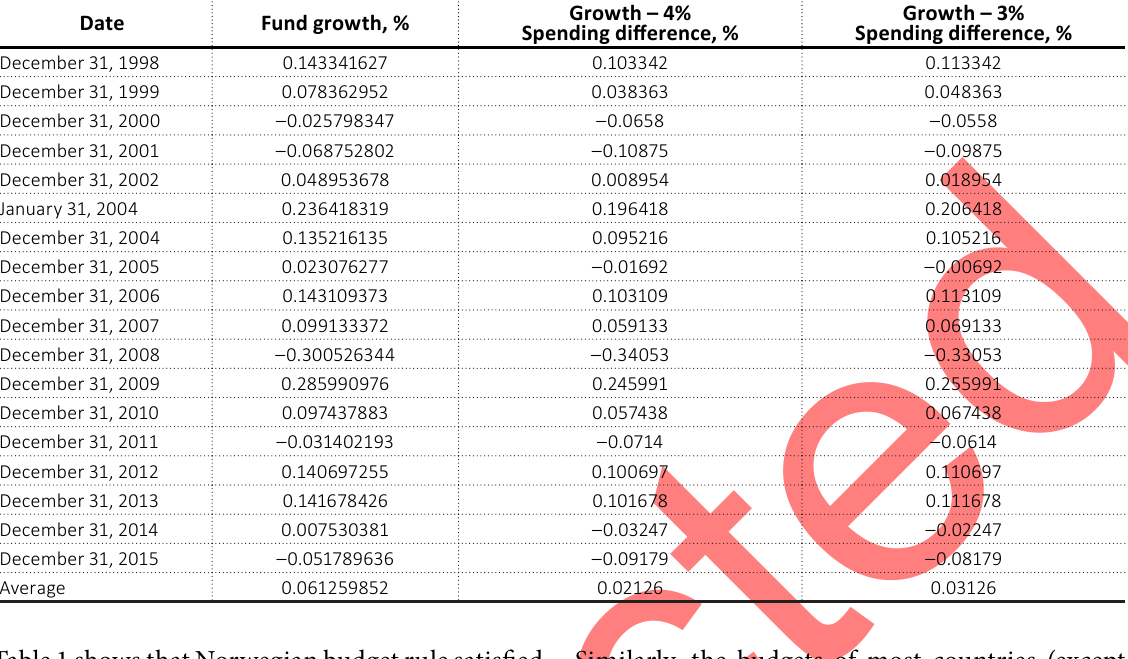
Source: Authors’ calculation, Thomson